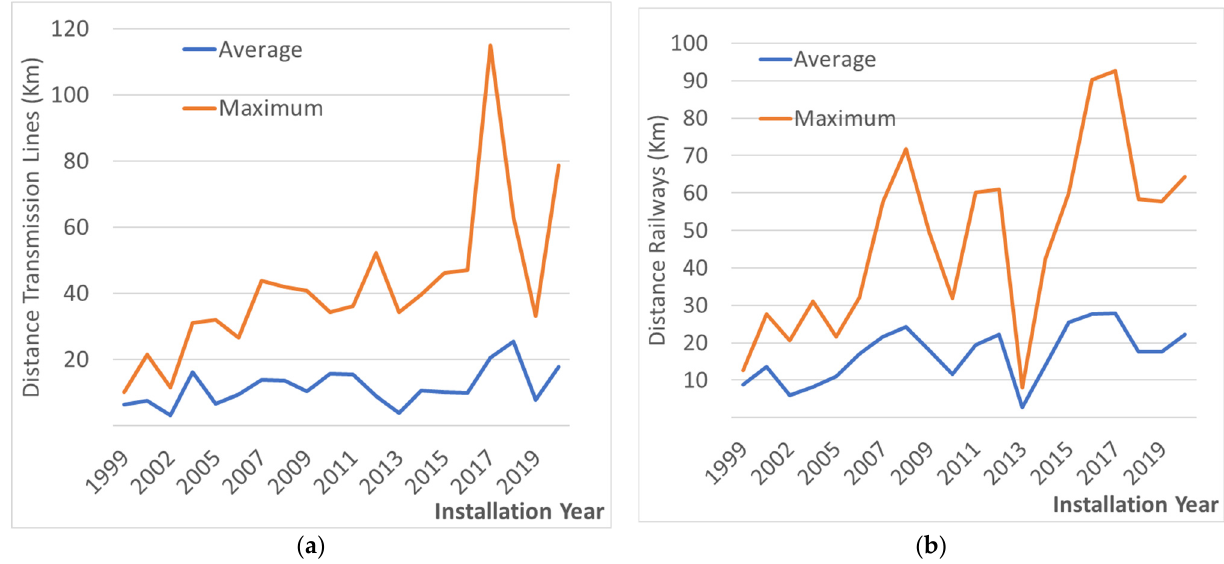
Figure 12. Distance change over time for Texas wind turbines to closest infrastructure. ( a ) Maximum and average distance of wind turbine to closest EHV. ( b ) Maximum and average distance of wind turbine to closest railways.